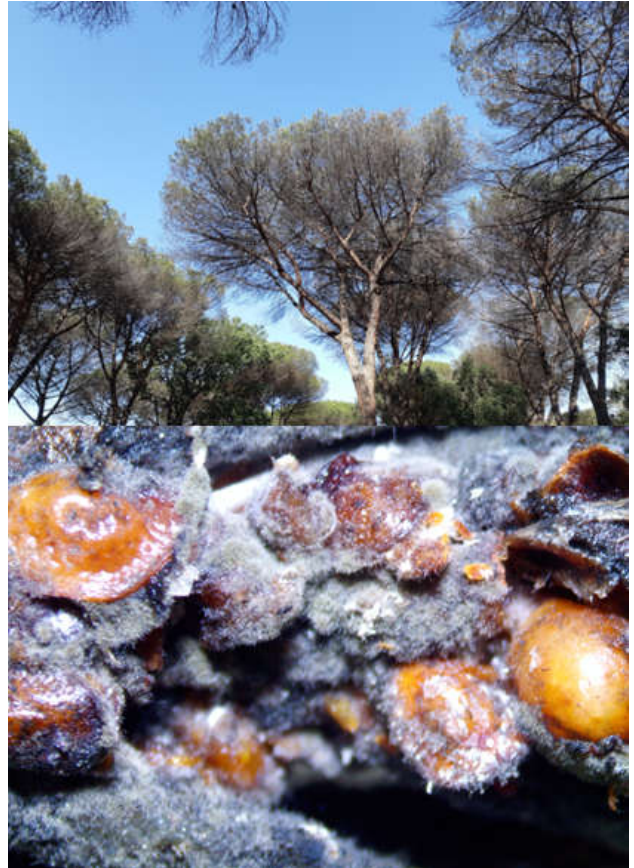
Figure 2. Symptoms on Pinus pinea plants infested by Toumeyella parvicornis : dying tree ( up ) and infested twig with adult females, honeydew, and mold ( bottom ). Table 1. List of bioclimatic variables considered for modelling. Variables used in the Species Distribu- tion Models (SDMs) are reported in